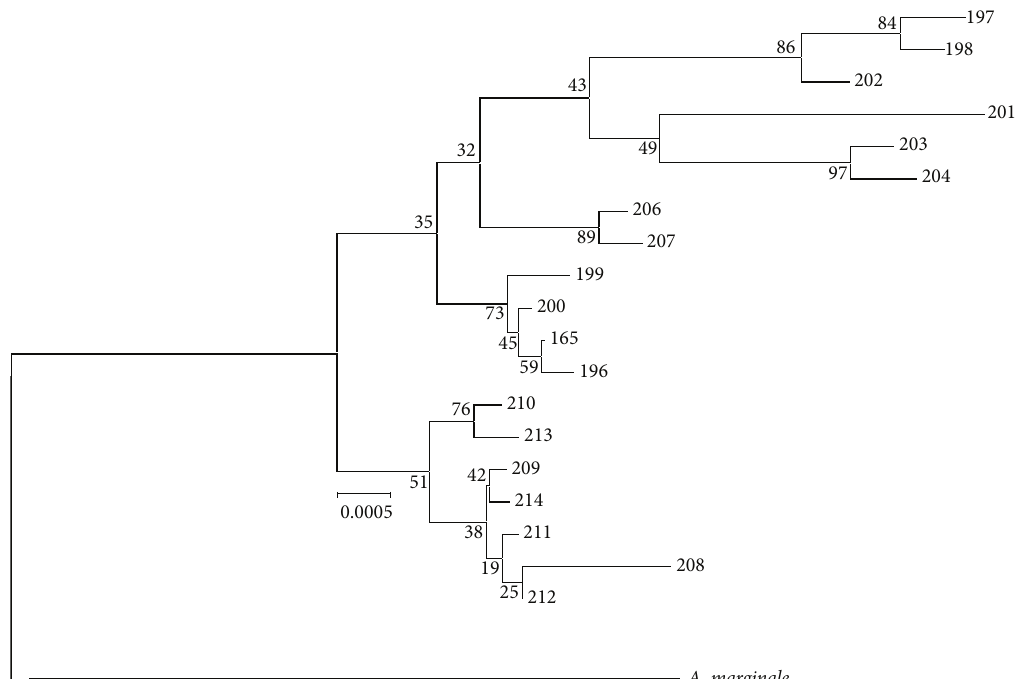
Figure 1: Neighbor-joining tree (boot strapped 500 iterations) with concatenated A. phagocytophilum sequences. The tree is rooted with sequences from A. marginale . All strains are numbered by their sequence type as described in Table